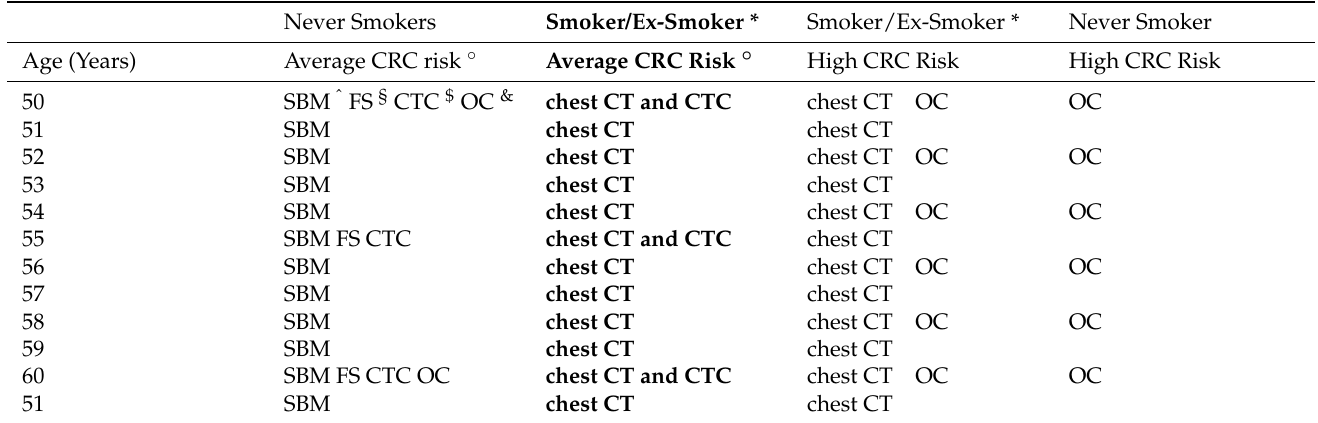
Table 1. CRC and LC screening regimens in subjects 50–75 years old according to the 2021 USP- STF